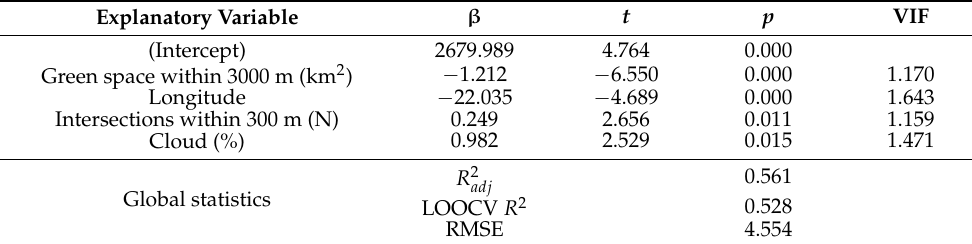
Table 5. Final results of the NO 2 model for daytime (9 a.m.–5 p.m.).